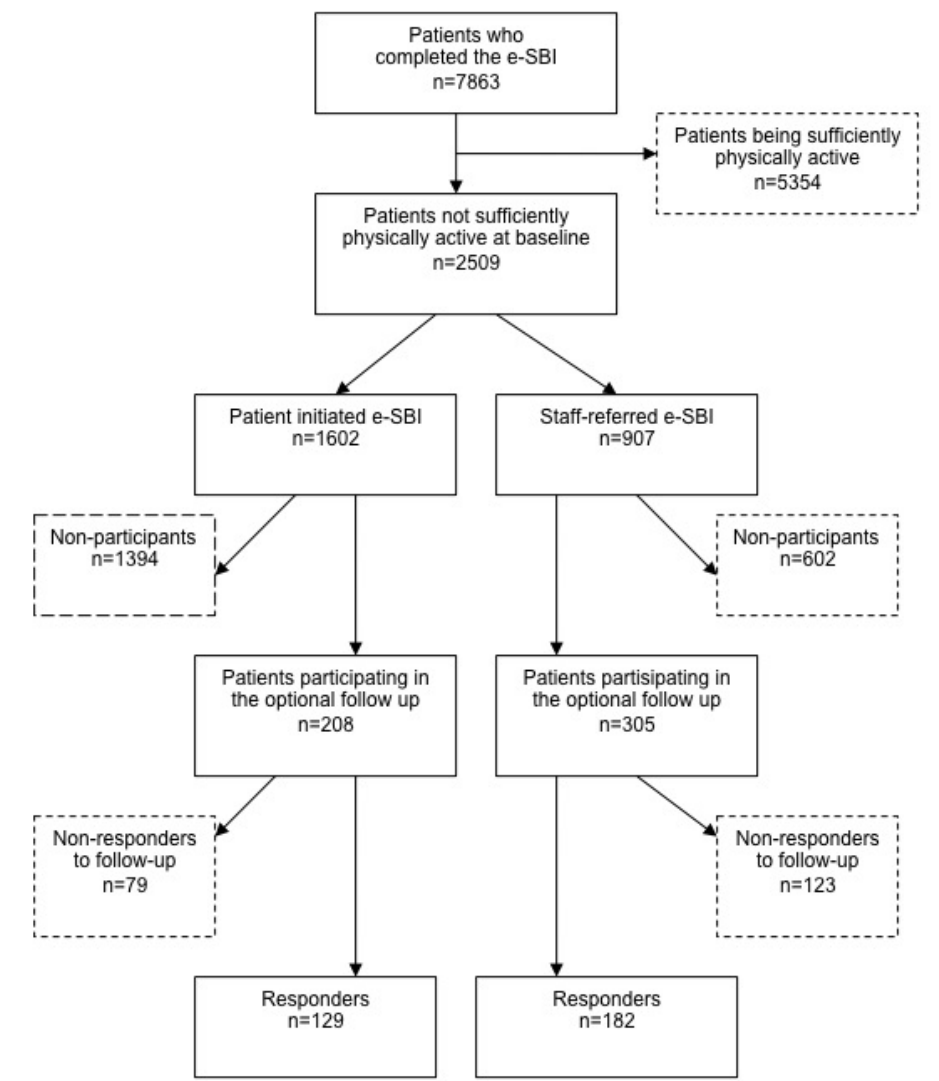
Figure 2. Flowchart of the recruitment of